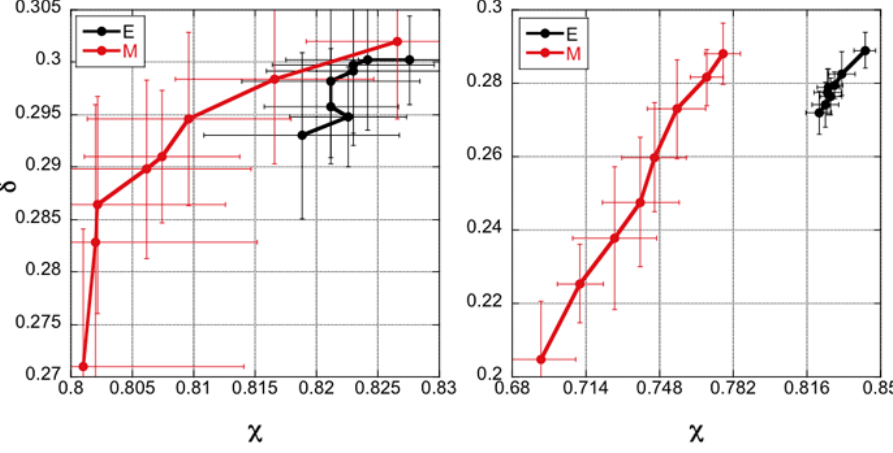
Fig. A3. Depolarization ratio as a function of color ratio, based on dust particulate properties. These panels correspond to Fig. 5a and b according from Left to Right.